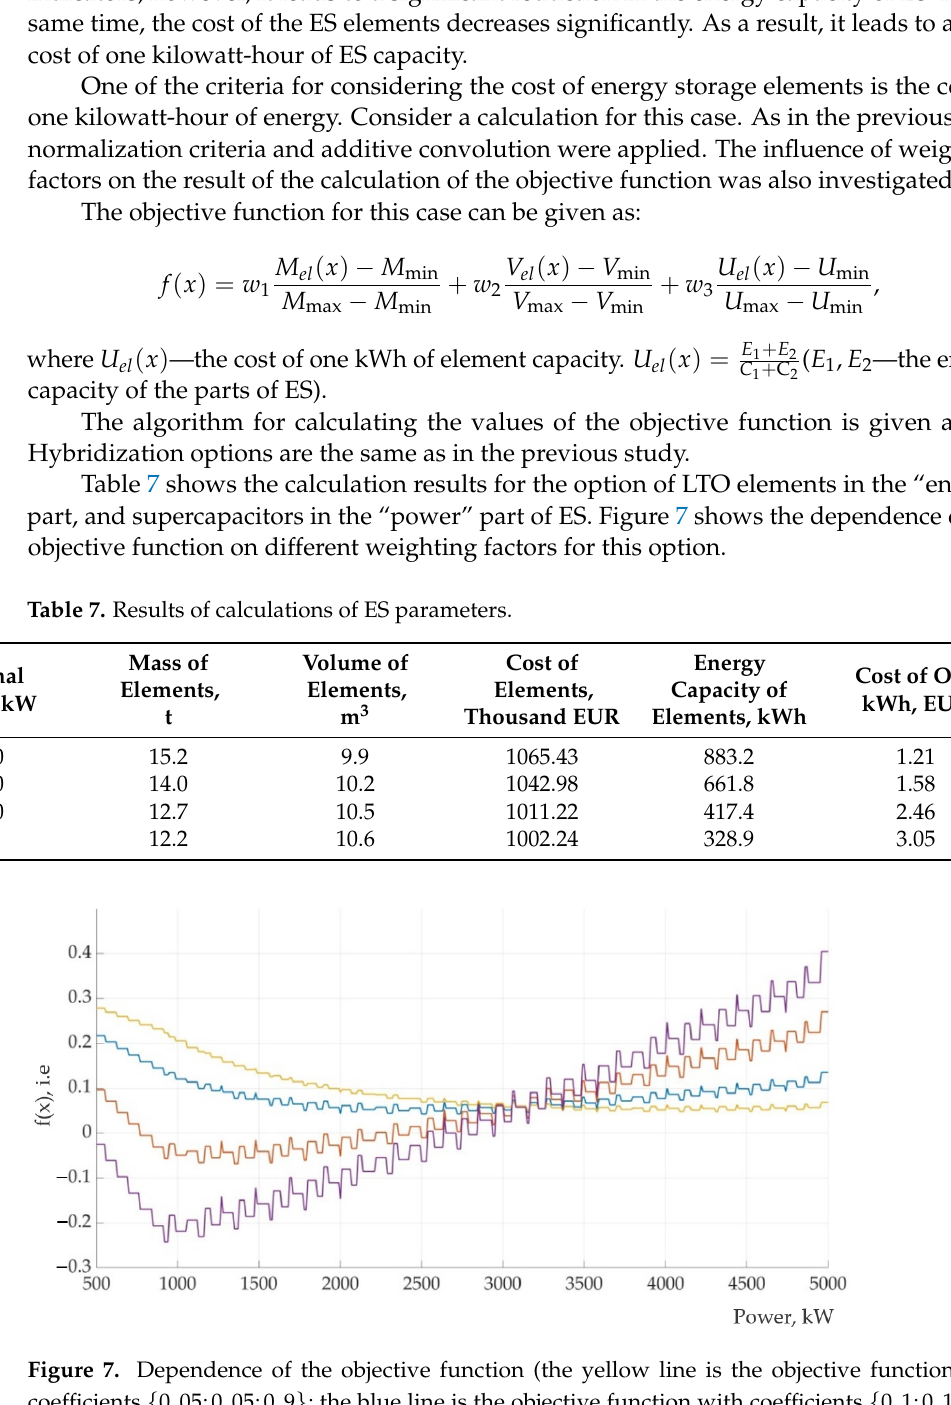
Table 8. Results of calculations of ES parameters with hybridization of LFP elements and superca- pacitors.